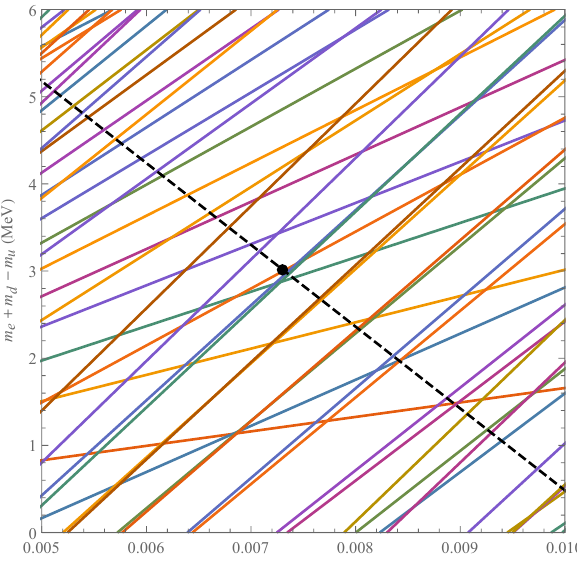
Figure 3. Nuclear stability thresholds for elements from the first three rows of the periodic table. The black dot represents our values. The black dashed line is the maximally sensitive direction, averaged over these isotopes. Each domain in the figure has fixed abundance ratios, and the thresholds correspond to the abrupt changes displayed in Figure